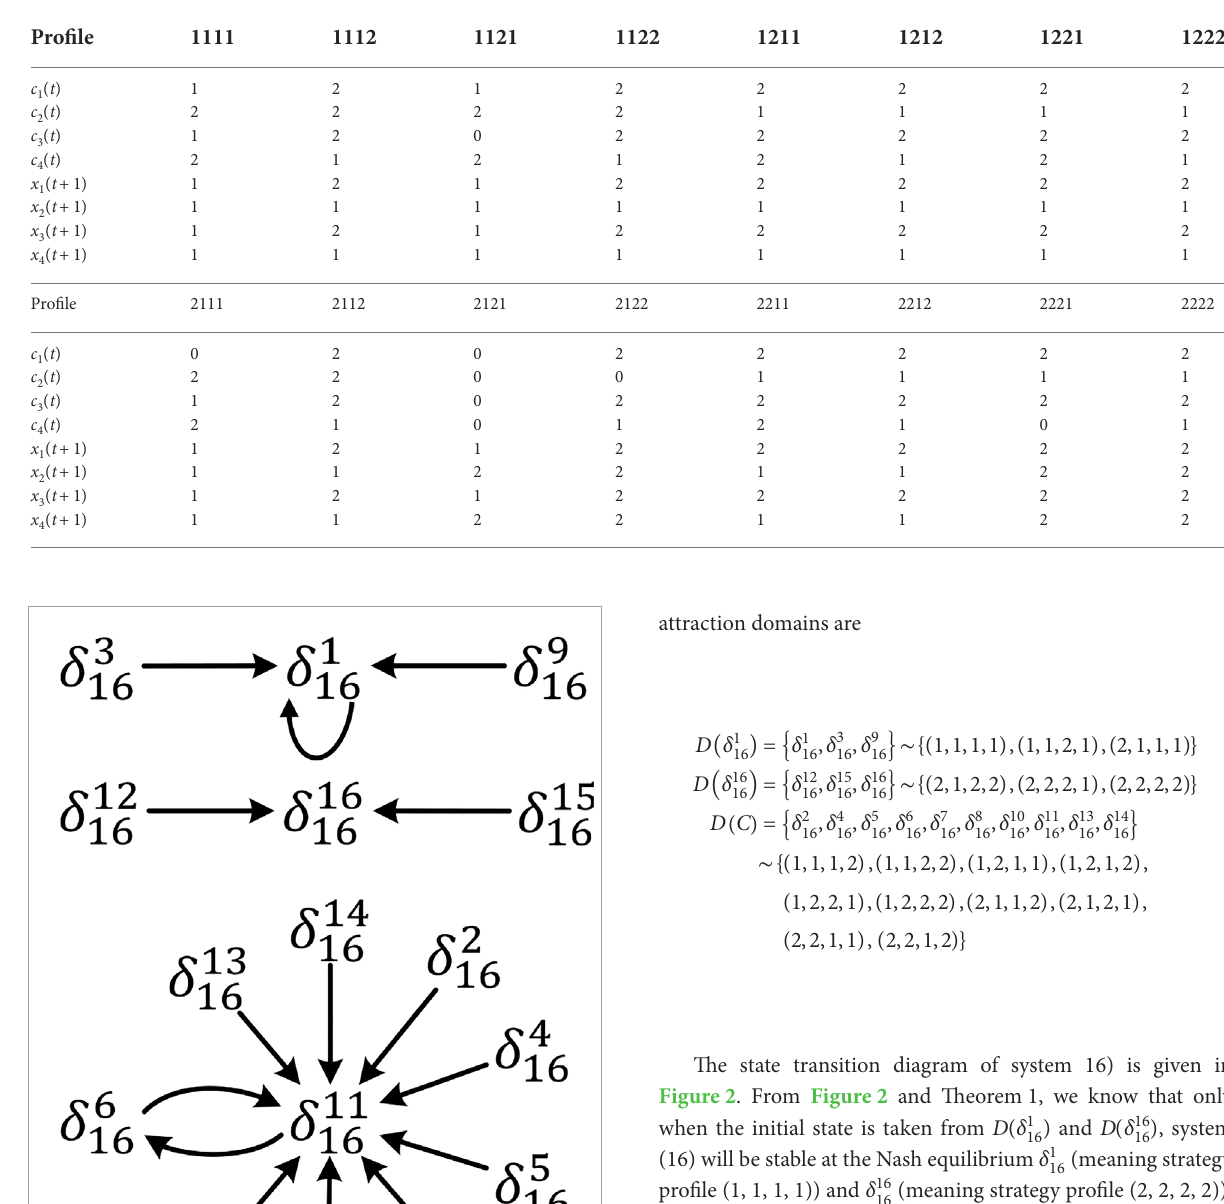
Figure 2 . From Figure 2 and Theorem 1, we know that only when the initial state is taken from D ( δ 1 (16) will be stable at the Nash equilibrium δ 1 profile (1, 1, 1, 1)) and δ 16